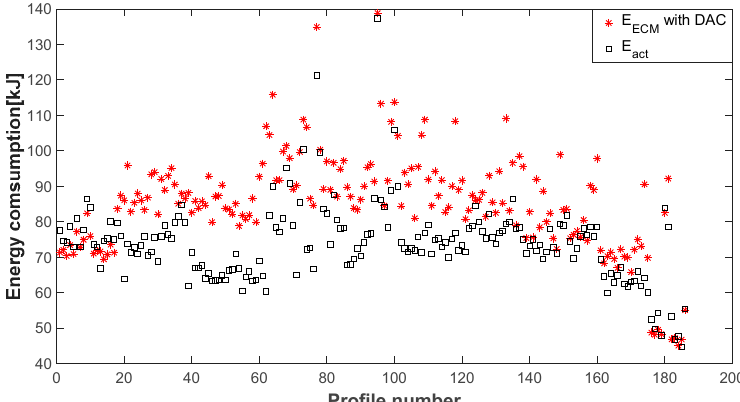
Figure 7. The actual energy consumption and energy consumption calculated by the ECM considering the DAC.